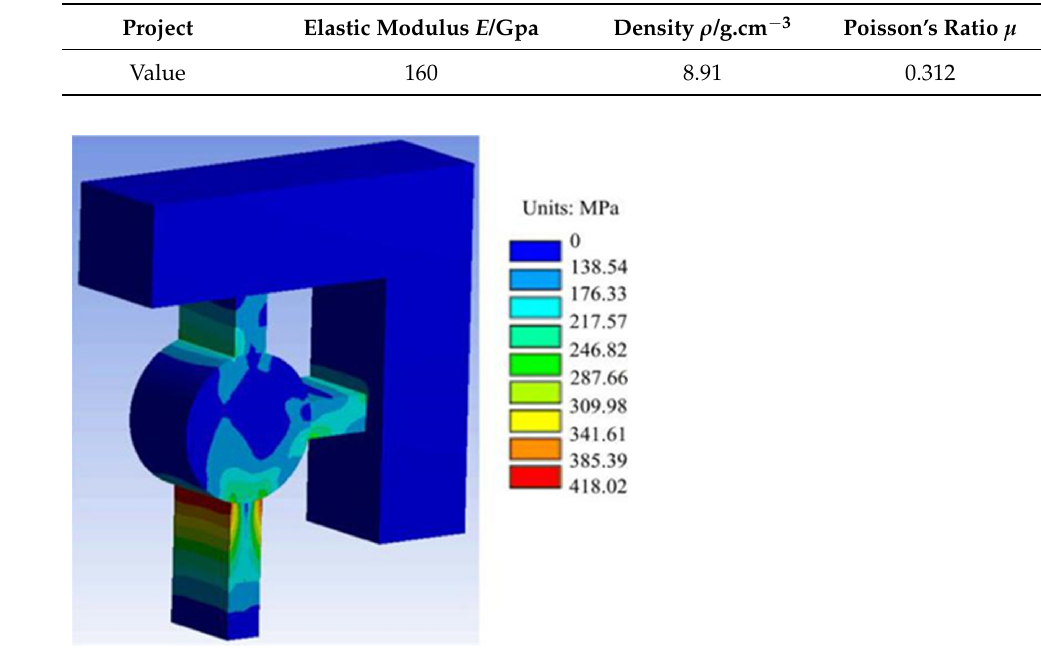
Figure 7. Stress nephogram. Table 1. Material parameters of the shear pin.